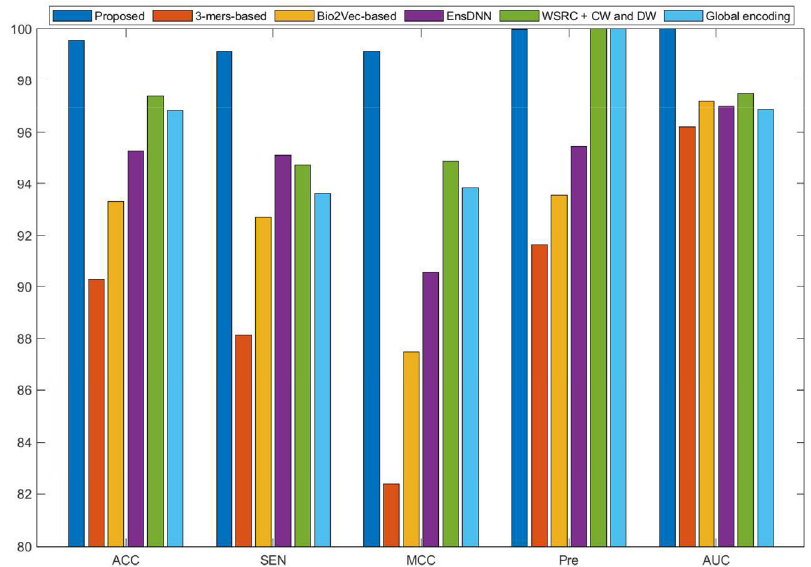
Figure 4. Comparison results of di ff erent methods on the yeast data set.